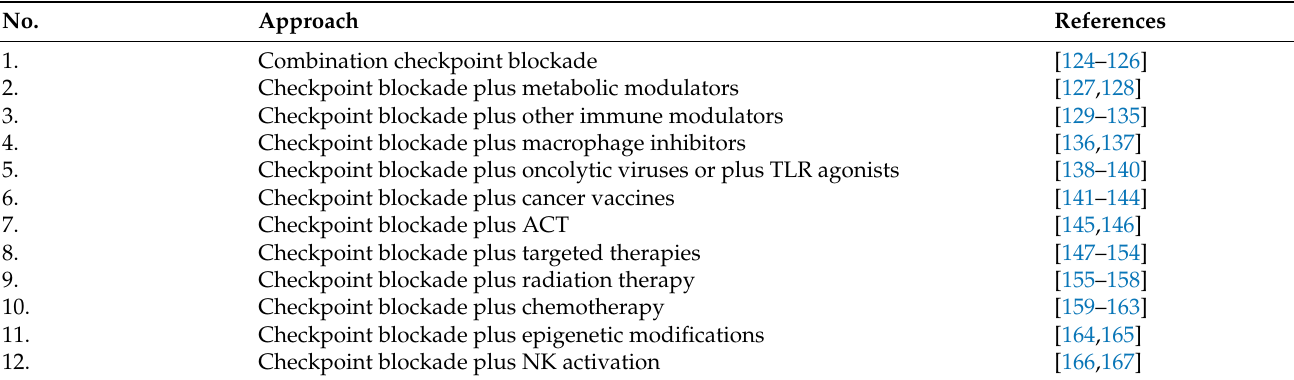
Table 1. Proposed combinatorial therapies to overcome resistance to cancer